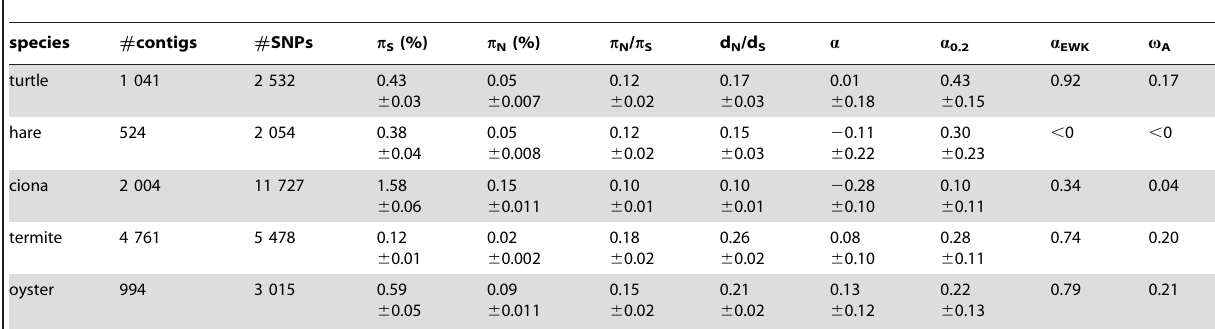
Table 3. Coding sequence polymorphism and divergence patterns in five non-model animals.